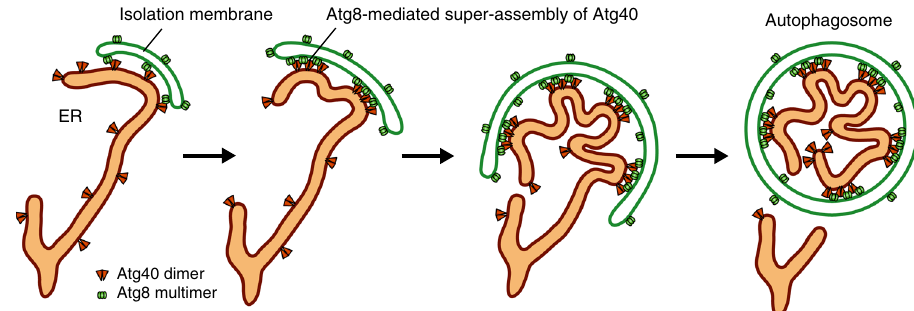
Fig. 7 Model for local ER remodeling by Atg40 during ER-phagy. When autophagosome formation initiates in the vicinity of the ER, Atg40 dimers are trapped and assembled at ER-isolation membrane contact sites through the interaction with Atg8 multimers on the isolation membrane. The resulting super-assembly of Atg40 bends the ER membrane with the reticulon-like function, leading to ef fi cient ER packing into